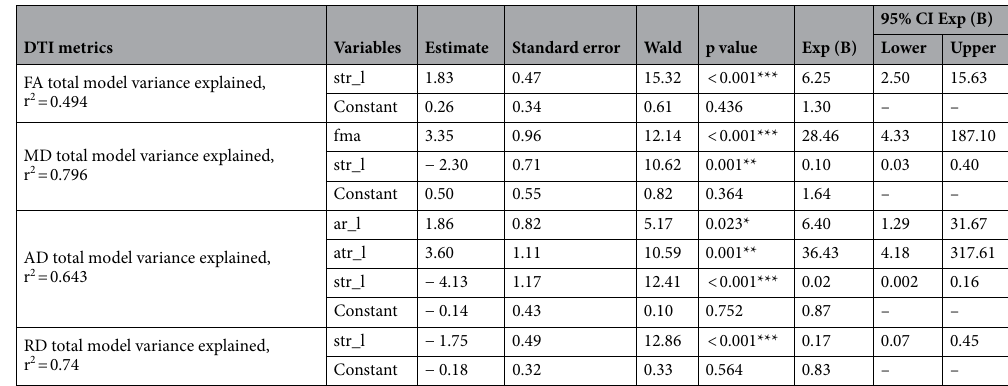
RD total model variance explained, r 2 = Table 2. Binary logistic regression model to predict ASD with optimal outcome in 4-years follow-up with 27 main fiber bundles. *p < 0.05; **p < 0.01; ***p < 0.001. FA fractional anisotropy, MD mean diffusivity, AD axial diffusivity, RD radial diffusivity, str_l the left superior longitudinal fasciculus, fma forceps major, ar_l the left acoustic radiation, atr_l the left anterior thalamic radiation.